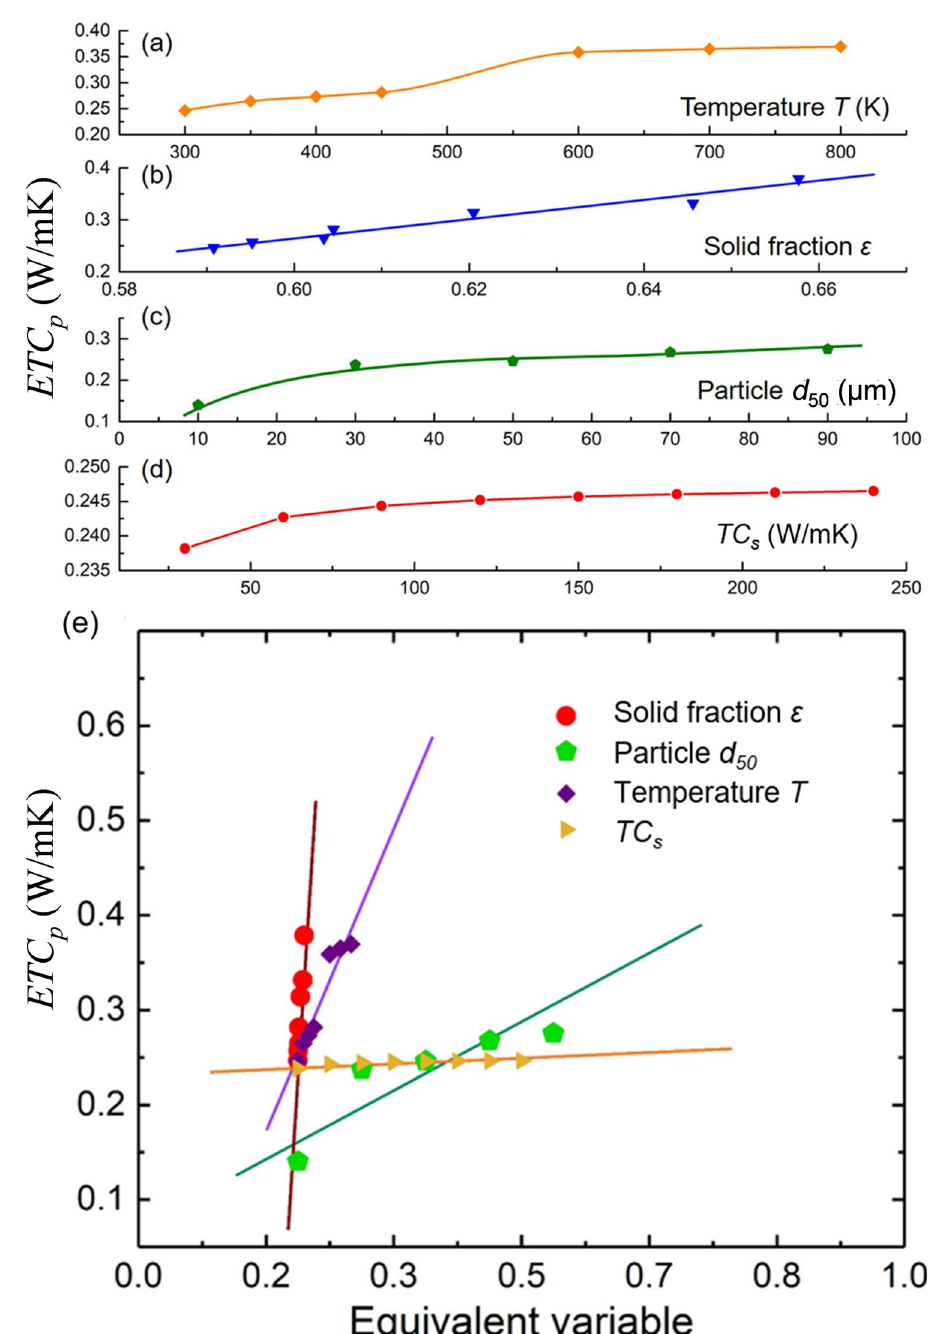
Figure 4 Trend of ETC p with parameters: a ‒ d ETC p changes with parameters; e ETC p sensitivity analysis of